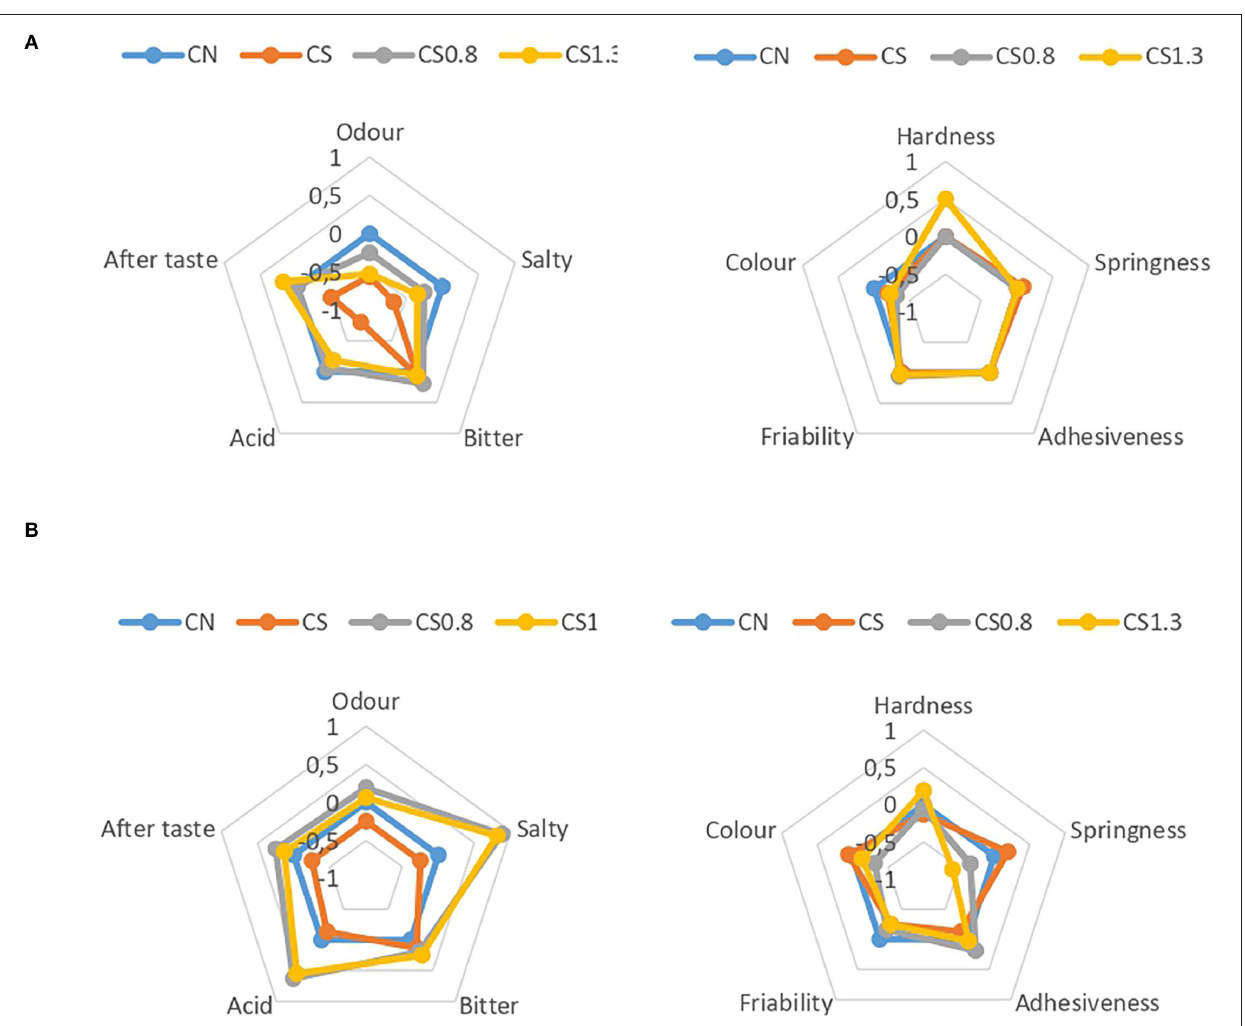
Frontiers in Nutrition |